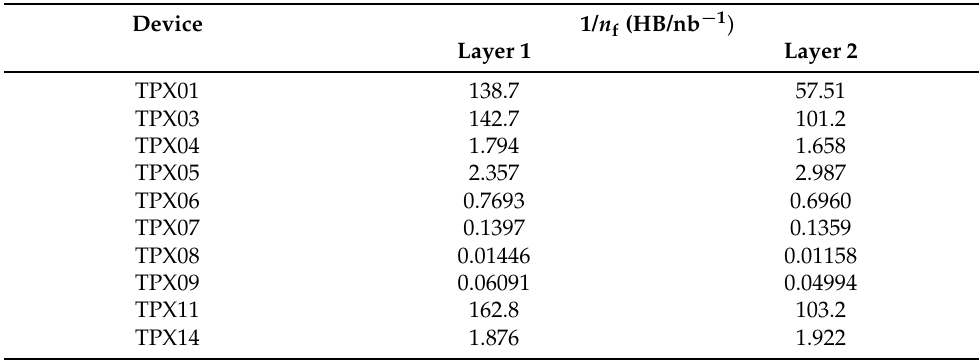
Figure 54. Thermal neutron (HB) rate per LB (for 100% acquisition time) versus TPX hit-counting luminosity per LB [14] for TPX04 layer 1. The slope of the linear fit gives the normalization factor between count rate and thermal neutron luminosity. The scatter of the points is larger than purely statistical with χ 2 /ndf = 3.5. Taken from Ref. [17]. Table 28. Inverse normalization factors (1/ n f ) to convert HB rates to luminosities. Taken from Ref.